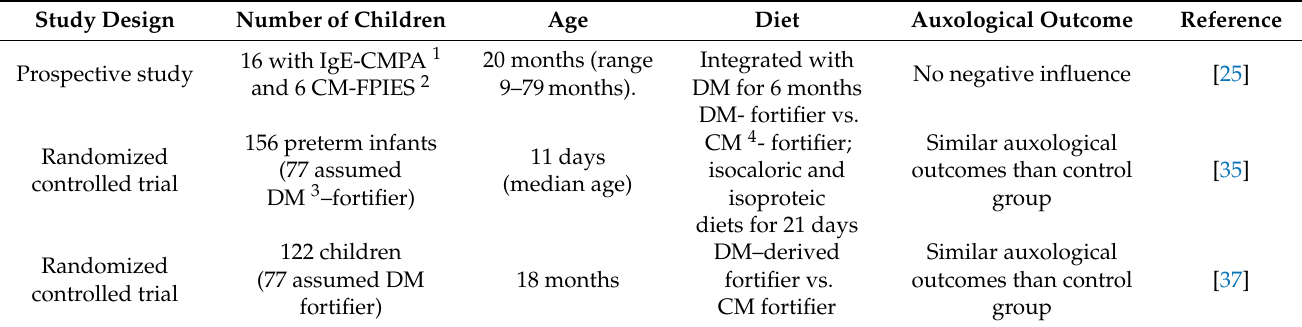
1 CMPA: cow milk protein allergy; 2 CM-FPIES: food protein-induced enterocolitis syndrome induced by cow milk; 3 DM: donkey milk; 4 CM: cow